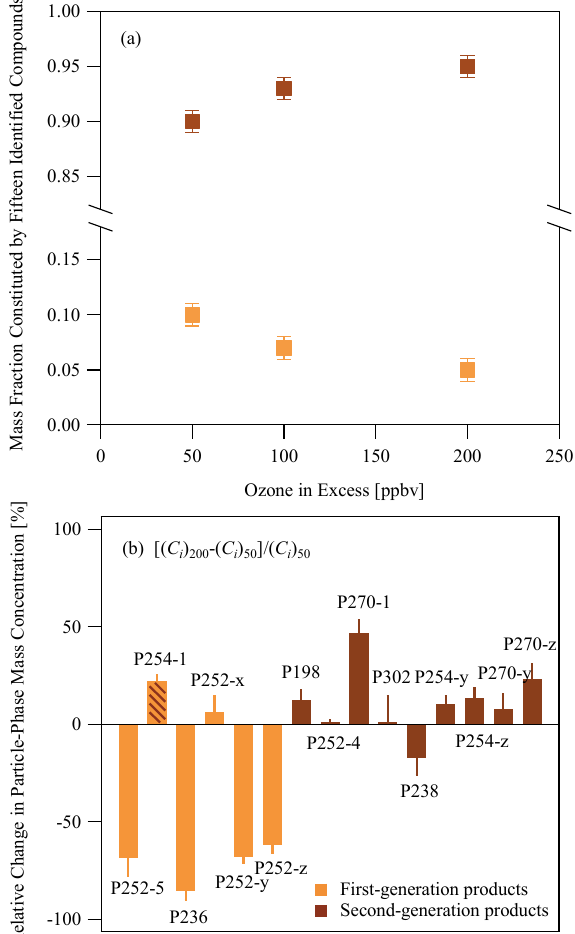
Fig. 4. (a) Mass fractions of first- and second-generation products for increasing ozone concentration, as quantified by UPLC-ESI- ToF-MS. The ordinate of mass fraction represents the sum of the mass concentrations of either the first- or second-generation prod- ucts divided by the combined sum of first- and second-generation mass concentrations, all measured by UPLC-ESI-ToF-MS for filter- extracted samples (Li et al., 2011). (b) The percent change in mass concentration at 50 compared to 200ppbv O 3 for the fifteen identi- fied products. Experiments in this figure are for 13ppbv of reacted β -caryophyllene. Error bars represent the one-sigma standard de- viation of three replicate experiments. Labels x, y, and z represent a permutation of 1, 2, and 3. P254-1 is hashed because the data of the present study suggest that this product might have been assigned incorrectly in previous work as a first-generation product (Li et al., 2011); it can instead be assigned as a second-generation product (see main